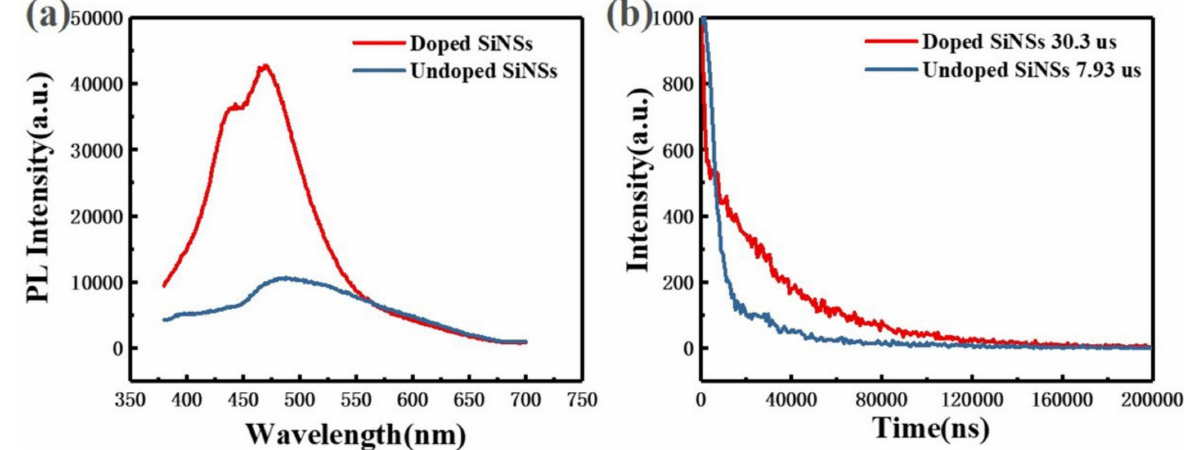
Figure 3. Optical characterization of undoped (blue line) and doped (red line) silicon nanosheets. ( a ) photoluminescence (PL) spectra; ( b ) transient photoluminescence (TR-PL)